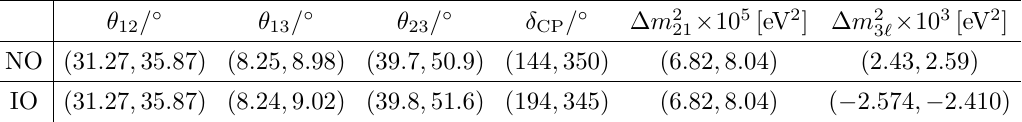
Table 2 . Global fit with 3 σ ranges based upon the observations of neutrino oscillations [22, 23]. µ → eγ µ → 3 e τ → eγ τ → µγ τ → 3 e τ → 3 µ CR ( µ − e, Ti)